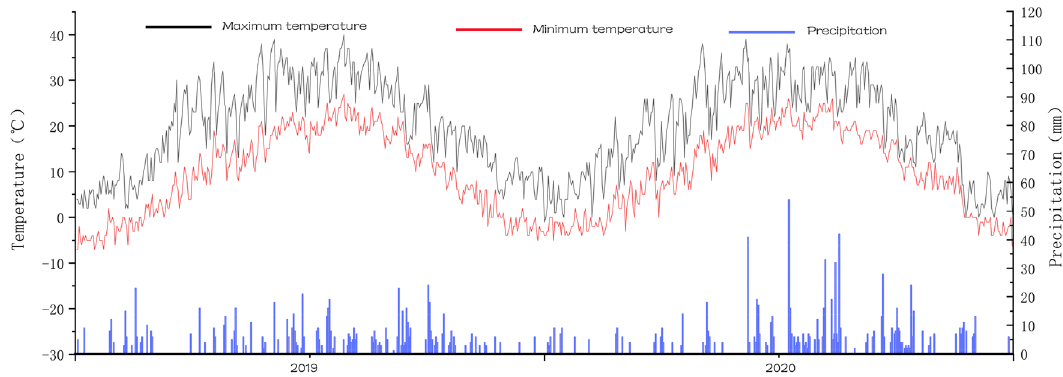
Figure 2. Precipitation and maximum and minimum temperatures during